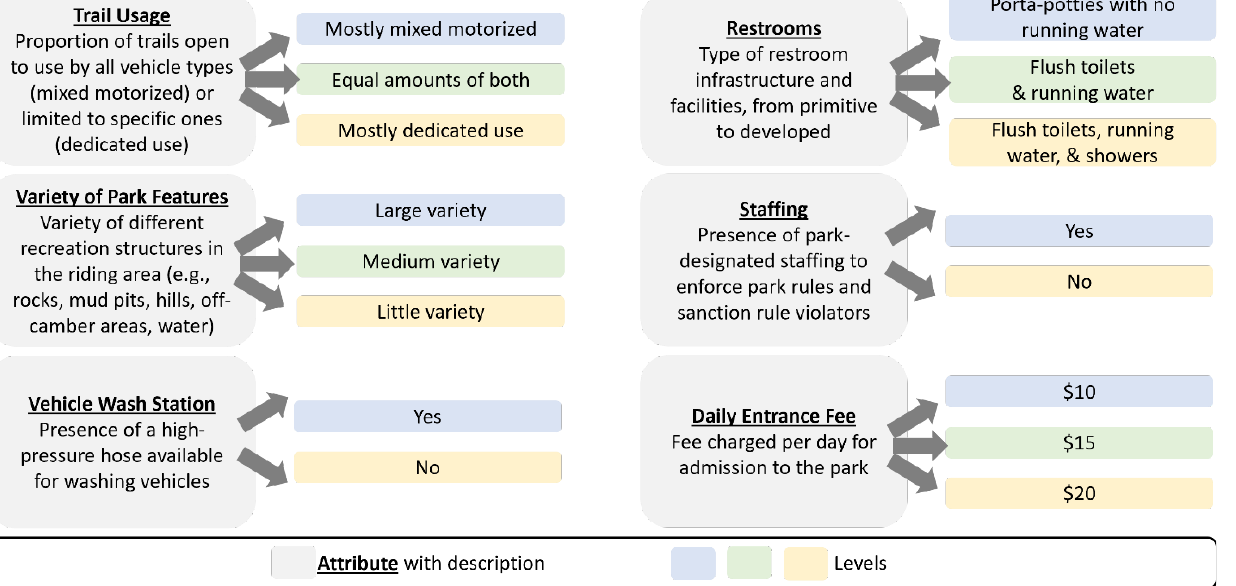
Figure 2. Attributes and levels used in the stated preference choice models.